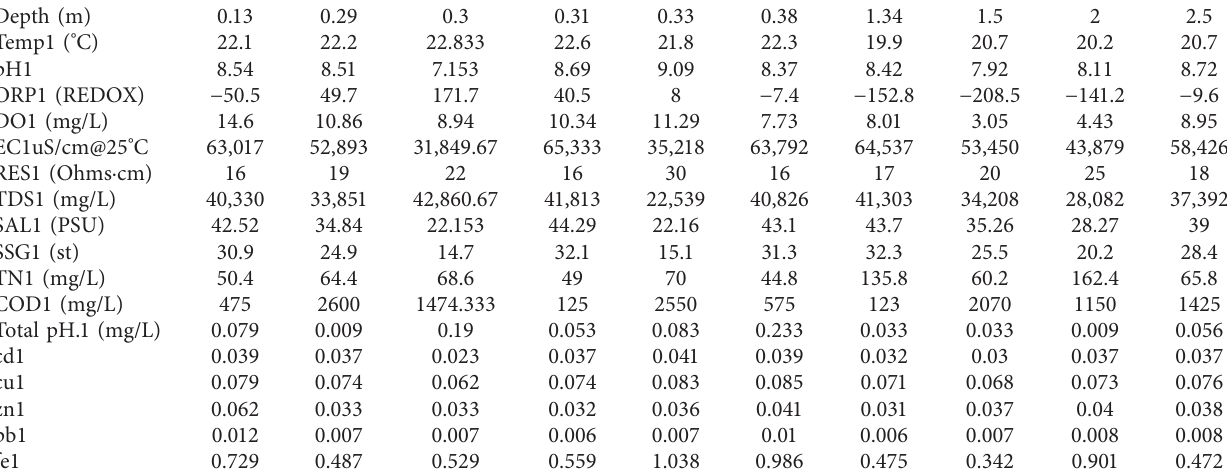
Table 1: Actual values of water elements at different depths of lake.